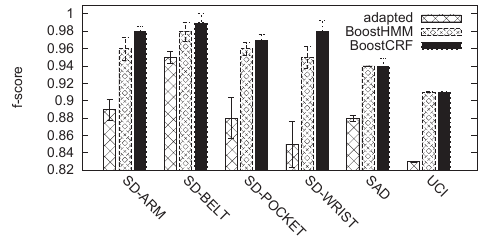
Figure 8: Combining adapted AdaBoost with HMM and